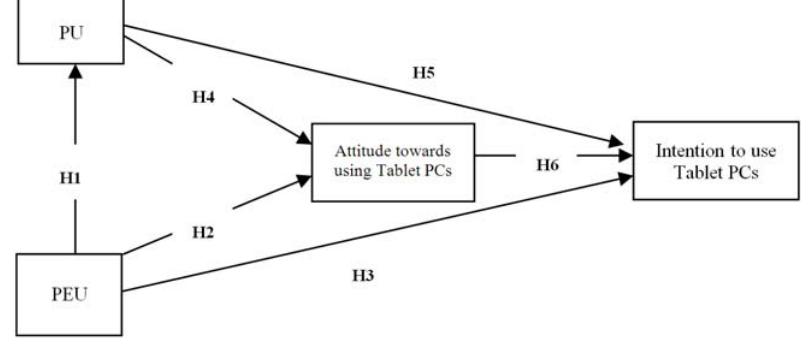
Fig. 2. Theoretical model of Tablet PC